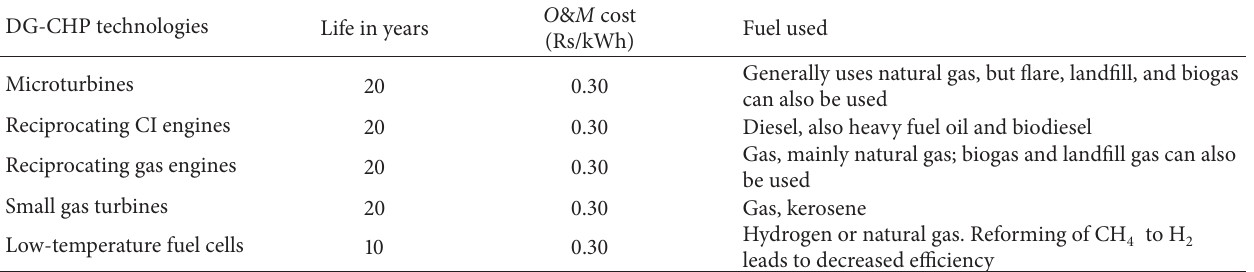
Source: table constructed on the basis of information found in [4] and data available in Rajasthan.